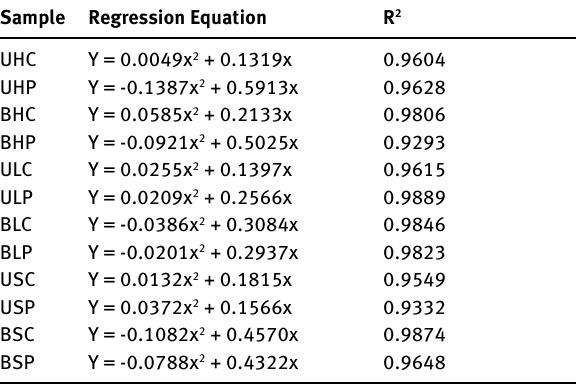
Table 1: Polynomial Regression Equation for the Drying Rate Curves of Cardaba banana and Plantain Slices Sample Regression Equation